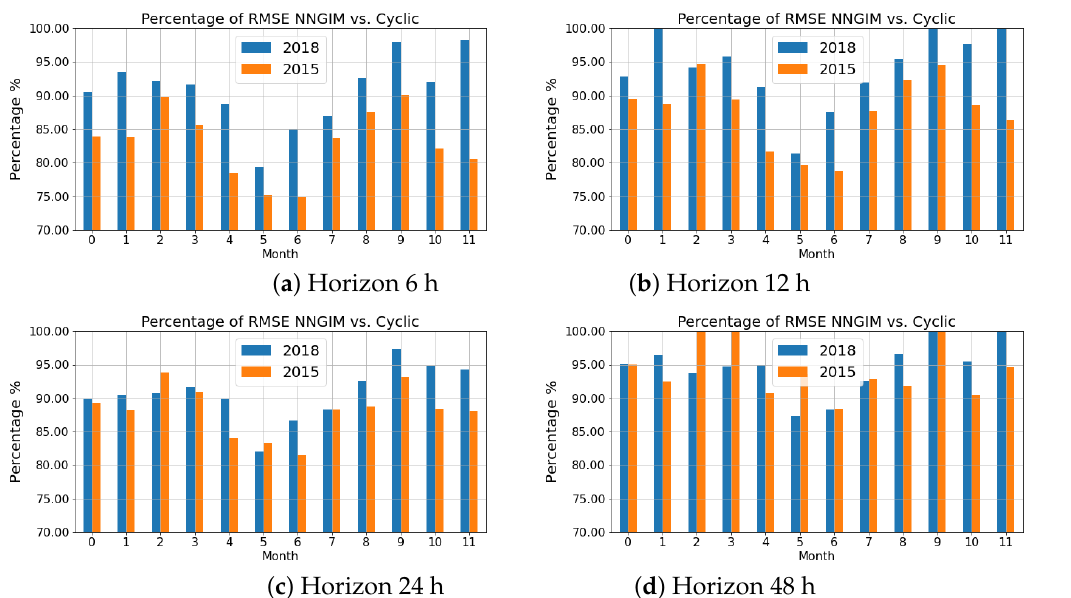
Figure 7. Percentage of RMSE reduction with regard to cyclic freezing for the horizons of 6 h, 12 h, 24 h, 48